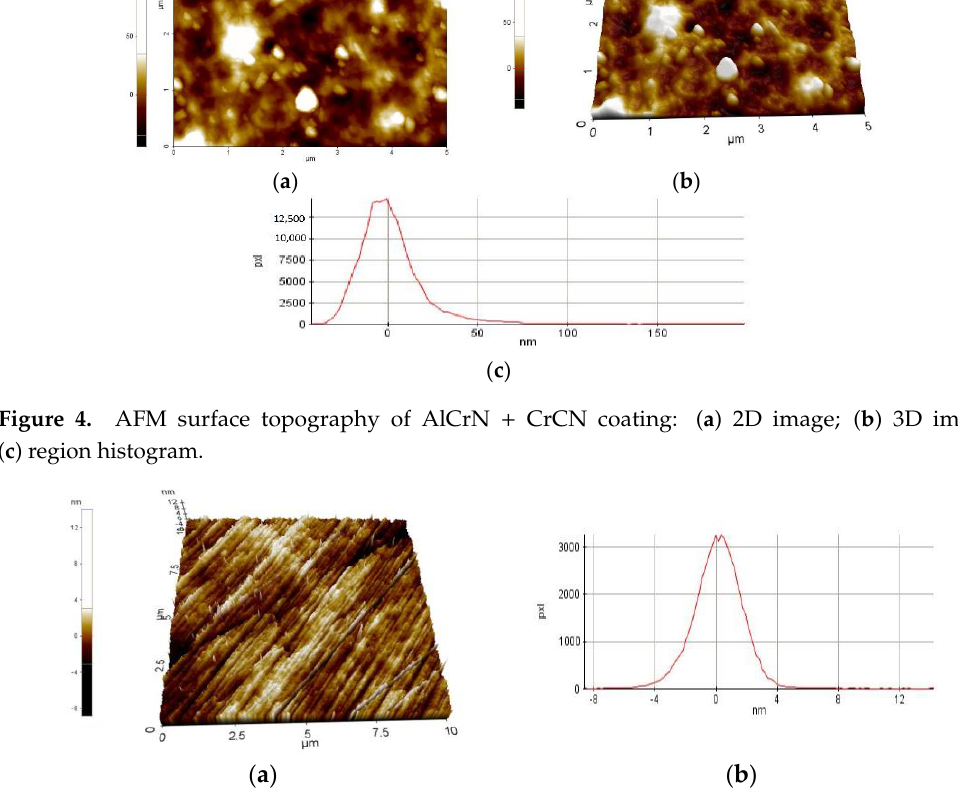
Figure 5. AFM surface topography of steel substrate: ( a ) 3D image, ( b ) region histogram.